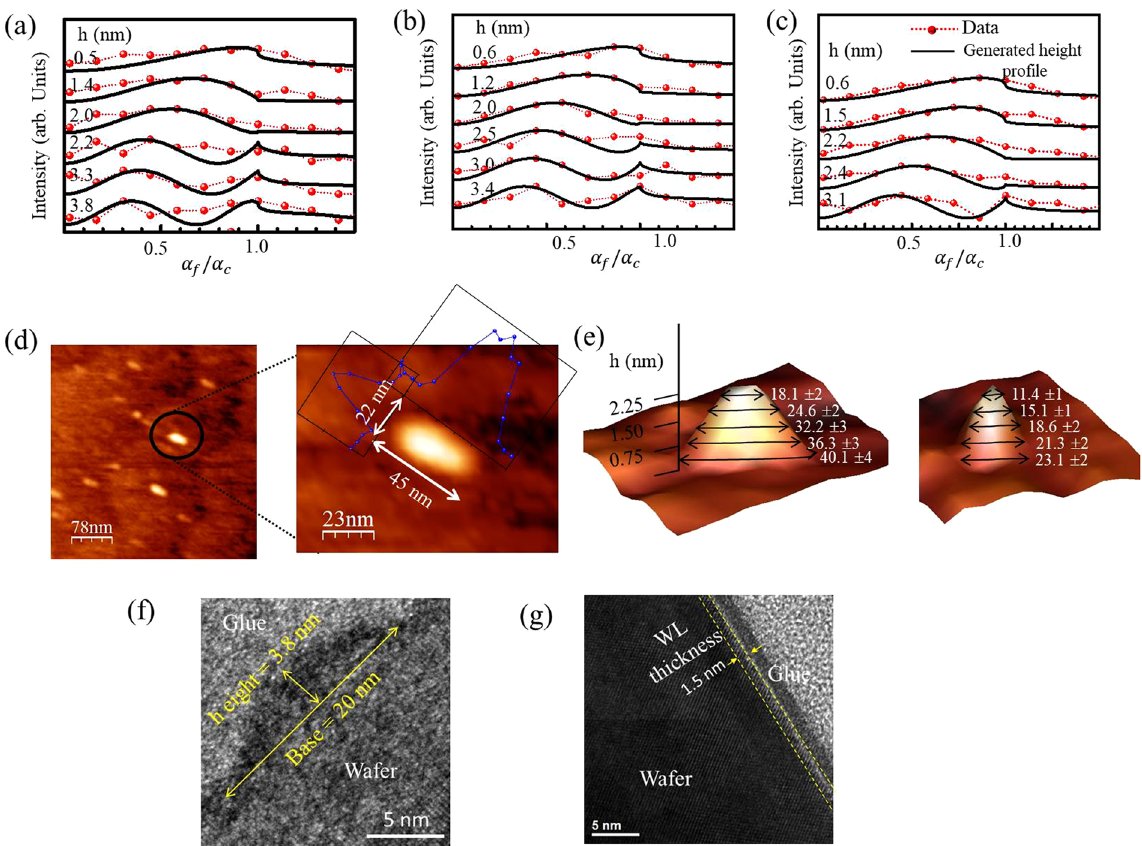
Figure 3. Line profiles of scattered intensity with respect to the ratio of exit angle of Mythen detector and critical angle of substrate for different in-plan lattice parameters of ( a ) uncapped [ a II = 0.57, 0.573, 0.576, 0.58, 0.589, 0.593, 0.596 in nm] ( b ) 5 nm [ a II = 0.57, 0.574, 0.578, 0.584, 0.587, 0.591 in nm] and ( c ) 30 nm [ a II = 0.57, 0.572, 0.576, 0.58, 0.588 in nm] capped QDs [for a II values top to bottom in the curves]. ( d ) Lateral dimensions of an elongated selected QD from AFM measurements. ( e ) Distribution (over 100 QDs) of lateral dimensions of QDs in two mutually perpendicular directions with heights of uncapped QDs obtained from AFM measurement. ( f ) X-TEM image shows a particular QD having base dimension of 20 nm related to minor axes dimension of QD and height of 3.8 nm, ( g ) X-TEM image shows wetting layer thickness of 1.5 nm indicated by yellow dotted